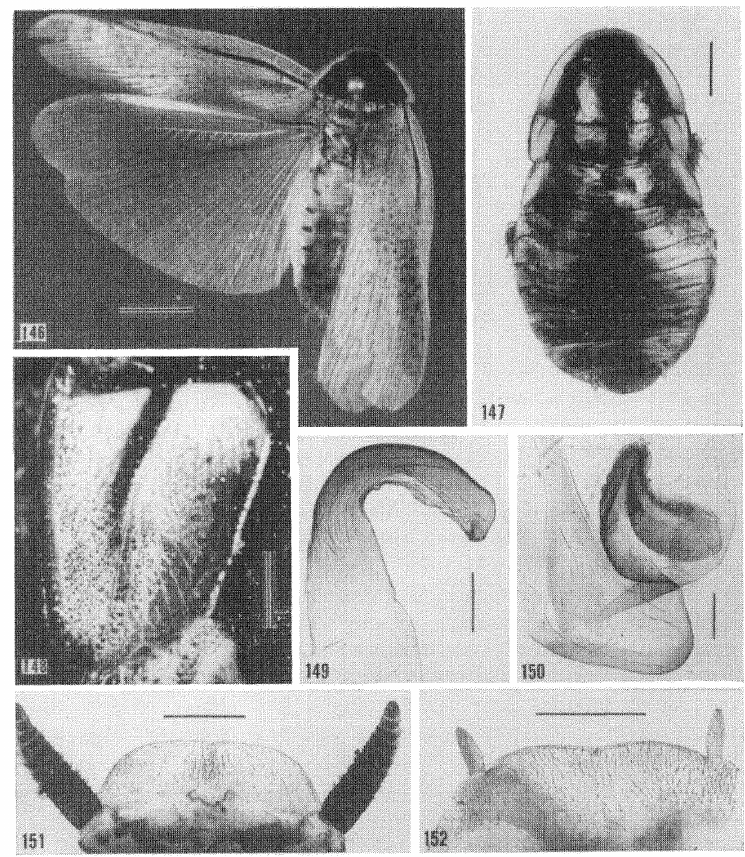
Figures 146-152. Calolampra solida. 146. (268 L in SM), holotype, Peak Downs, Q. 147-148. ? (4 L in SM), paratype, Peak Downs, Q. 147. Dorsal view. 148. Tegmen of ?. 14.9-152. Genitalia, supra-anal plate, and hypandrium of holotype shown in figure 14.6. Scale: Fig. 146 6 mm; Fig. 147 4 mm; Figs. 148, 151-152 mm; Figs. 149-150 0.2